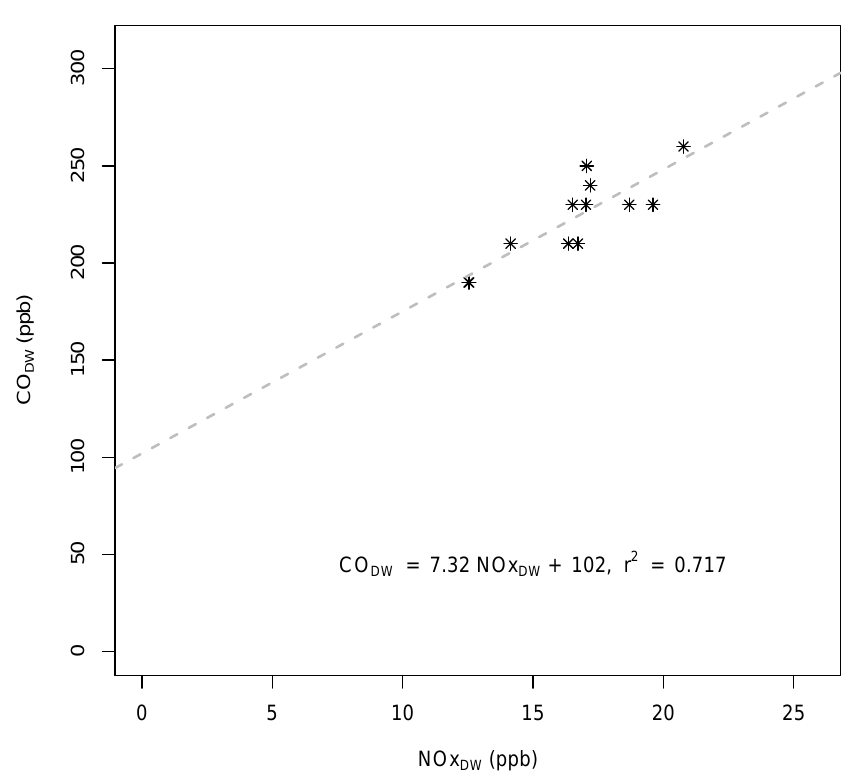
Figure 1. Example of CO:NO x ordinary least squares (OLS) regression methodology using 5-min-averaged measured concentrations to derive change (slope) in emissions for a one-hour increment of